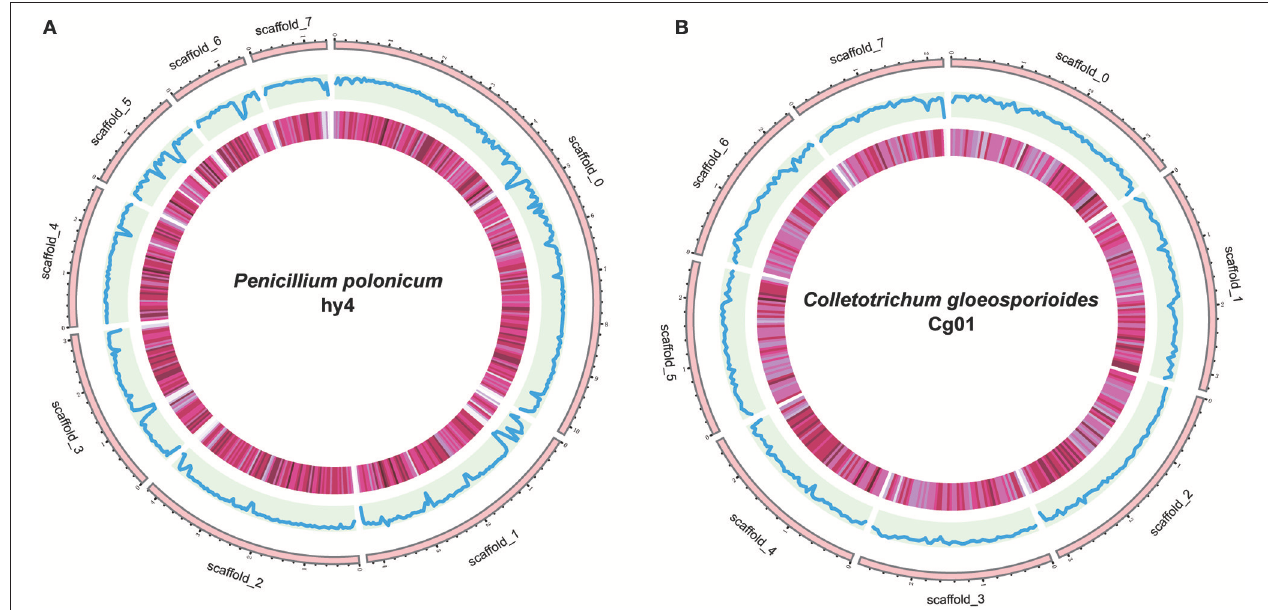
FIGURE 3 | Genome organization and gene distribution of P. polonicum hy4 (A) and C . gloeosporioides Cg01 (B) . From the outside inward, the first circle represents the scaffolds. Scaffolds 0–7 represent the longest eight scaffolds of hy4 and Cg01. The second circle indicates the GC content with the ratio of GC sites per 50kb